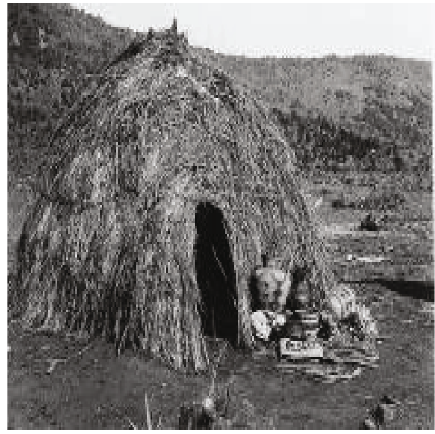
Figure 60: Apache wickiup